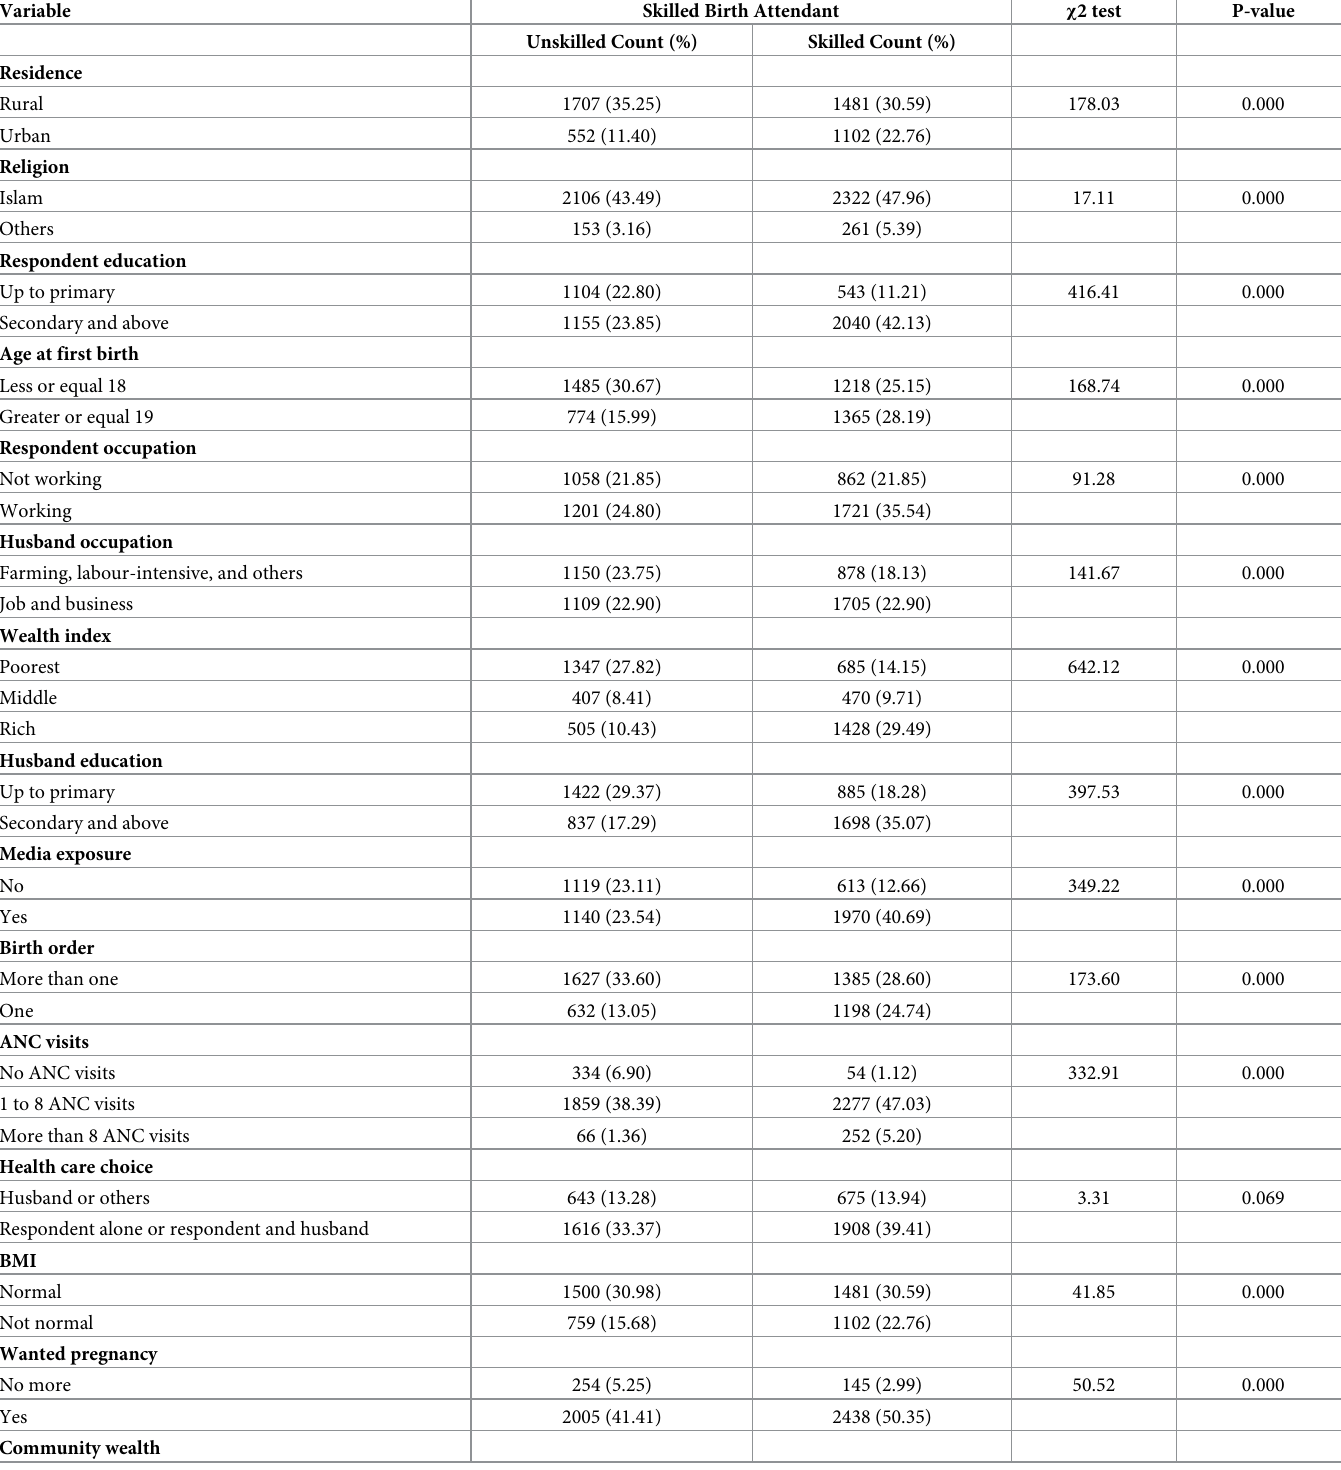
Table 2. Percentage distribution of individual and community characteristics for the selected predictors of women according to the SBAs, using the χ 2 test (bivari- ate